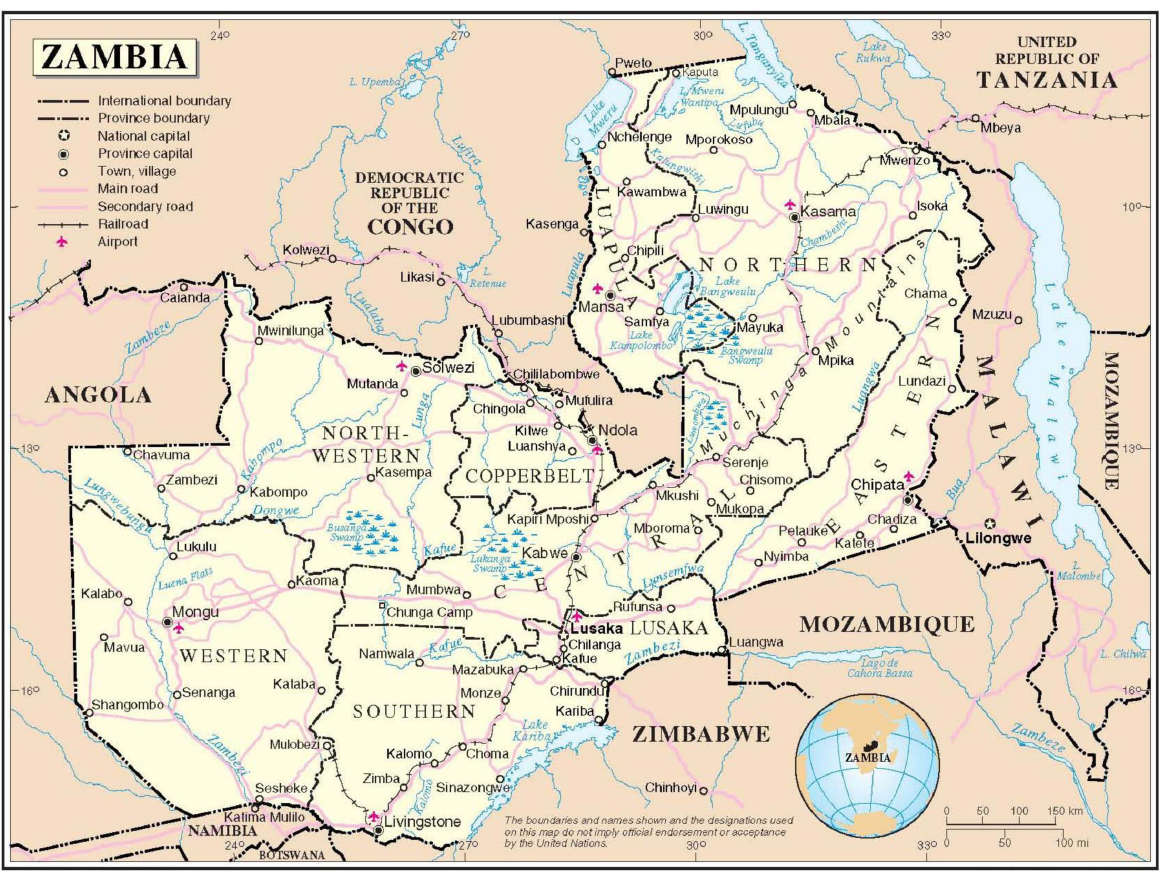
Figure 1. Zambia Map No. 3731 Rev. 4 reprinted under a CC BY license, with permission from the United Nations, original copyright January 2004.